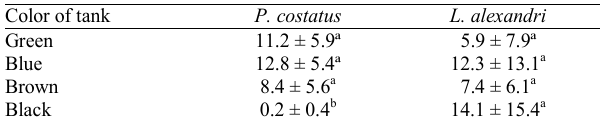
Table 4. Average values (± standard deviation) of number of prey larva -1 for curimatá-pioa ( Prochilodus costatus ) and pacamã ( Lophiosilurus alexandri ) cultivated in tanks of four different colors, after 10 days. Averages in the same column followed by different letters differed significantly (P<0.05) by Tukey’s